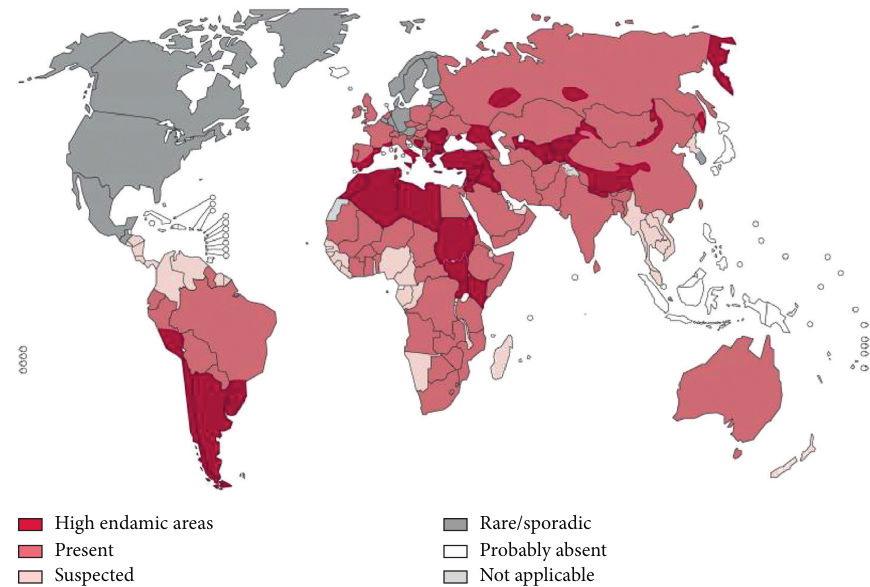
Figure 2: Distribution of Echinococcus granulosus and cystic echinococcosis worldwide (Source: